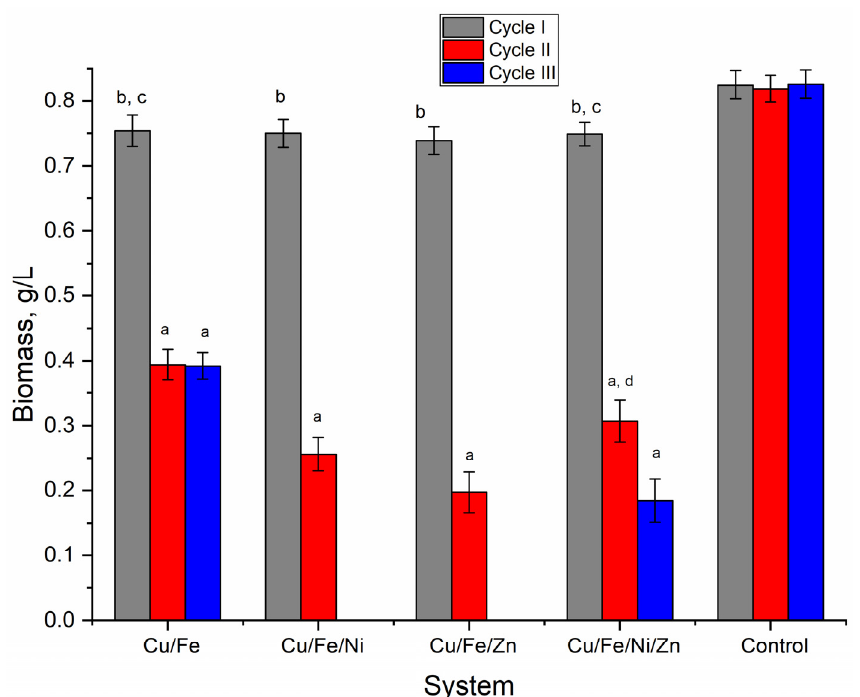
Figure 2. Nostoc linckia dry biomass accumulated at the end of three cultivation cycles in multimetal systems (a— p < 0.001 for the difference between experimental and control samples, b— p < 0.001 for the difference between the first and second cycle, c— p < 0.001 for the difference between the first and third cycles, and d— p < 0.001 for the difference between the second and third cycles) .